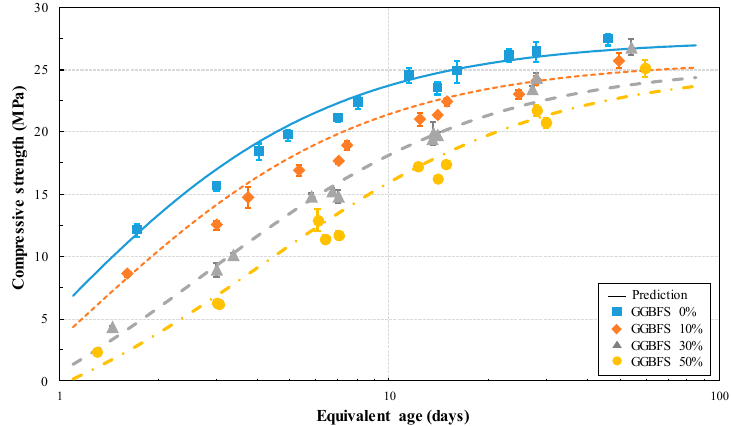
Figure 9. Prediction of compressive strength in concrete using GGBFS based on equivalent age.